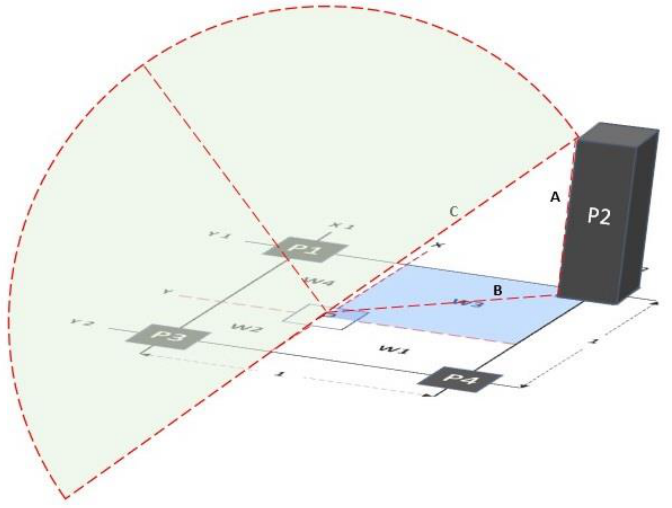
Figure 7. Example showing the virtual pixel length for hypotenuse-based radius for the area of the circle weighting scheme – this is the AC weighting scheme.